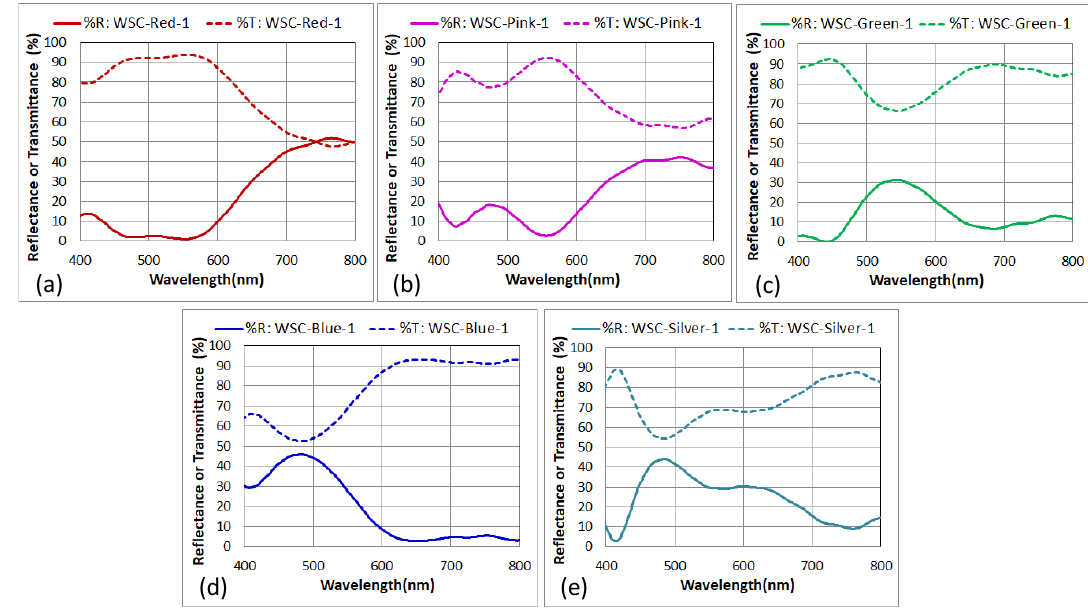
Figure 2. Reflectance (8 degrees light incidence) and Transmittance (0 degrees) for Design Strategy 1 wavelength-selective hard coatings: ( a ) WSC-Red-1, ( b ) WSC-Pink-1, ( c ) WSC-Green-1, ( d ) WSC-Blue-1, and ( e ) WSC-Silver-1. Wavelength selectivity is broadly tunable across the visible to near IR spectrum through interference layer design.